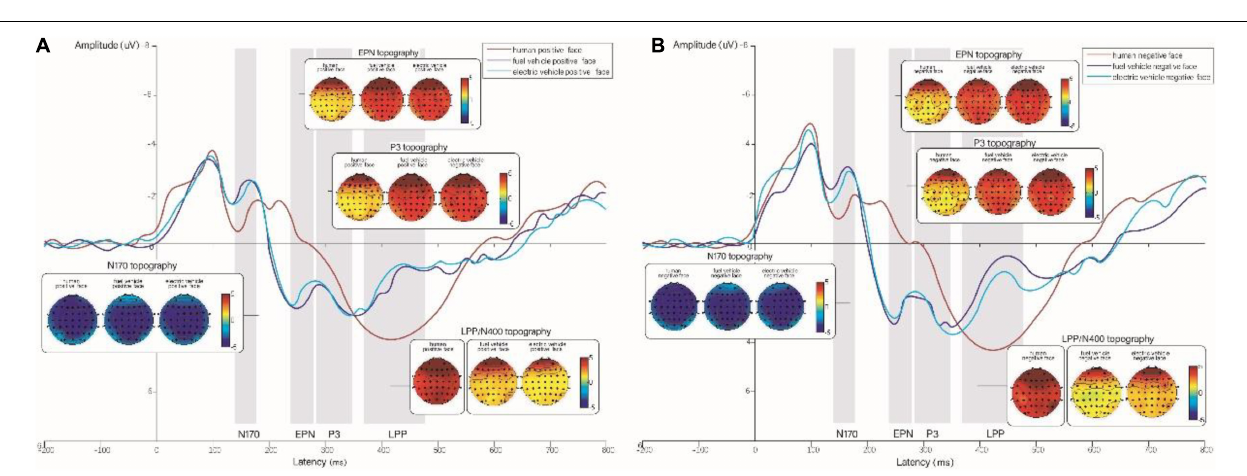
FIGURE 5 | (A) Grand-averaged ERPs for positive expressions on human, gasoline vehicle, and electric vehicle faces recorded in the electrodes of the occipital region and topographic maps corresponding to the experimental conditions. (B) Grand-averaged ERPs for negative expressions on human, gasoline vehicle, and electric vehicle faces recorded in the electrodes of the occipital region and topographic maps corresponding to the experimental conditions. The red line represents human faces; the purple line represents gasoline vehicle faces; the blue line represents electric vehicle